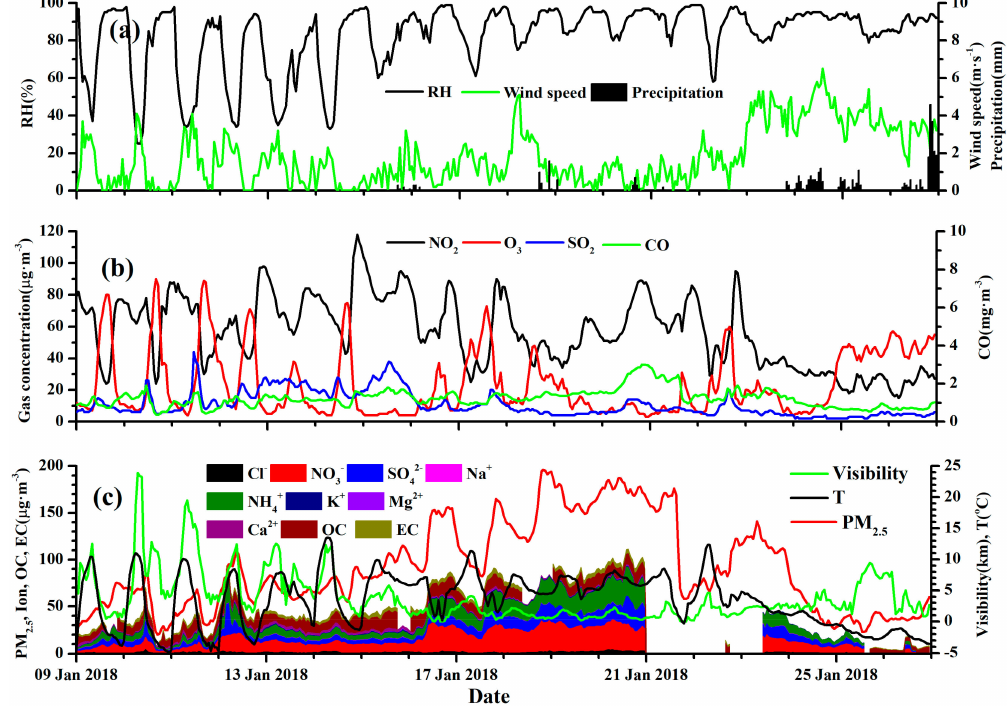
Figure 3. Time series of major meteorological elements ( a ), trace gases ( b ) and major air pollutants ( c ) during the observation